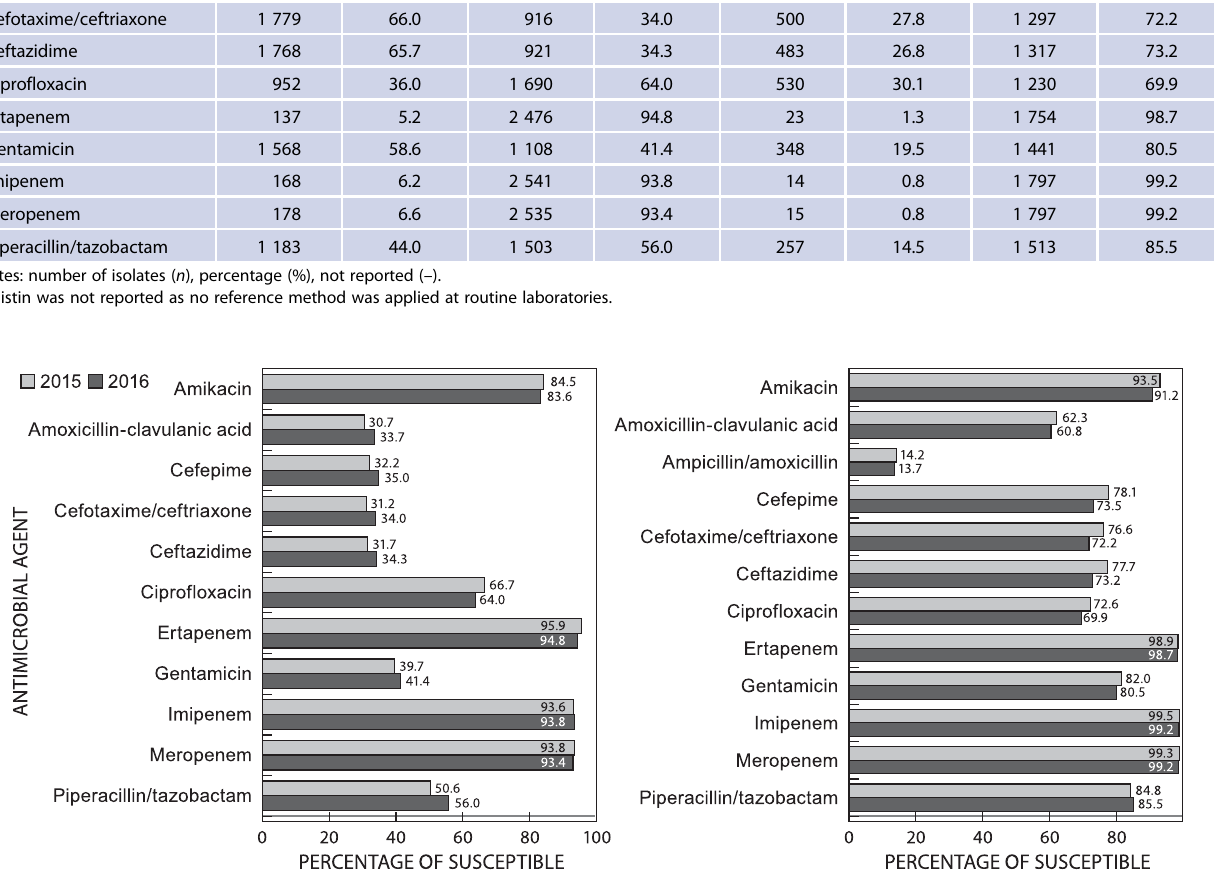
(Table 6). In comparison to 2015, isolates non-susceptible to gen- tamicin and amikacin increased but, susceptibility to carbape- nems and tigecycline remained constant (Figure 4). A high